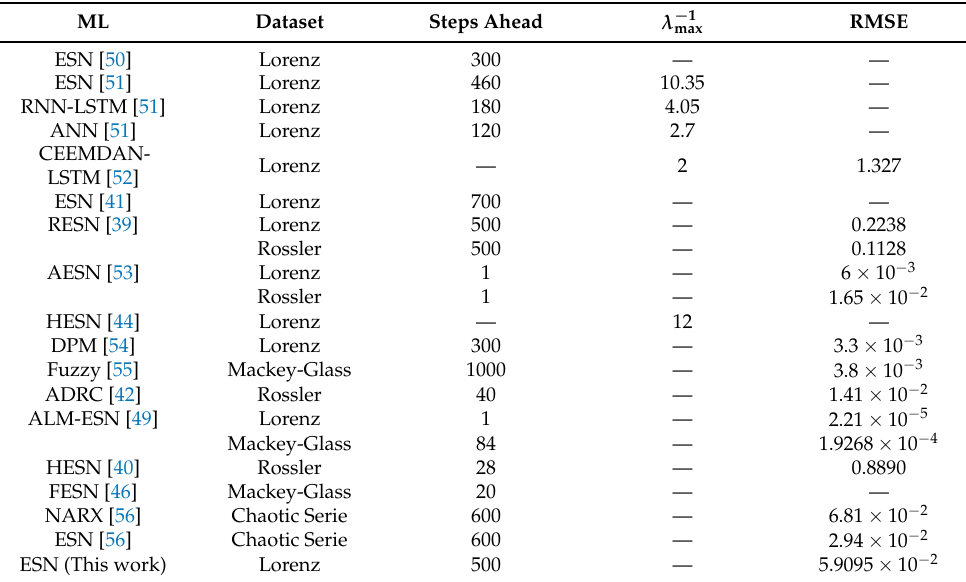
Figure 1. Predicting time series of the chaotic Lorenz system using ESN. Table 2. Prediction of chaotic time series using Machine Learning